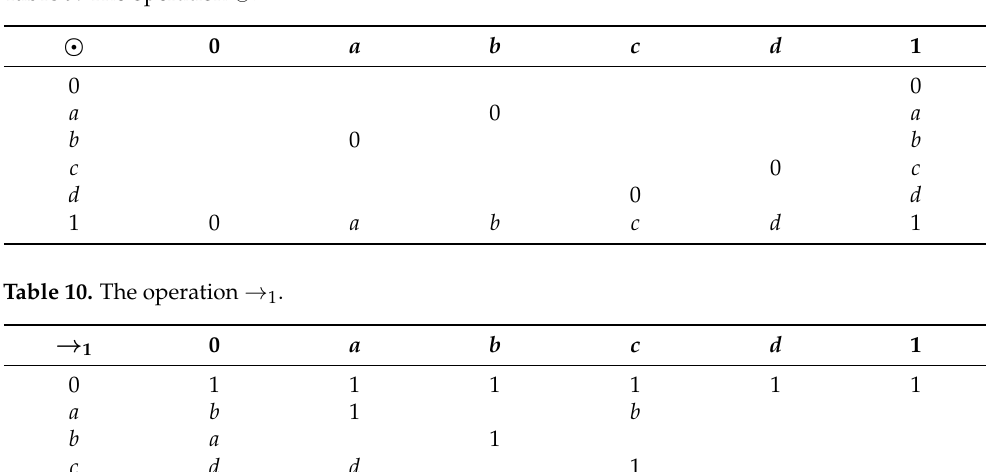
Figure 4. Hasse diagram of lattice L . Table 9. The operation (cid:12) .